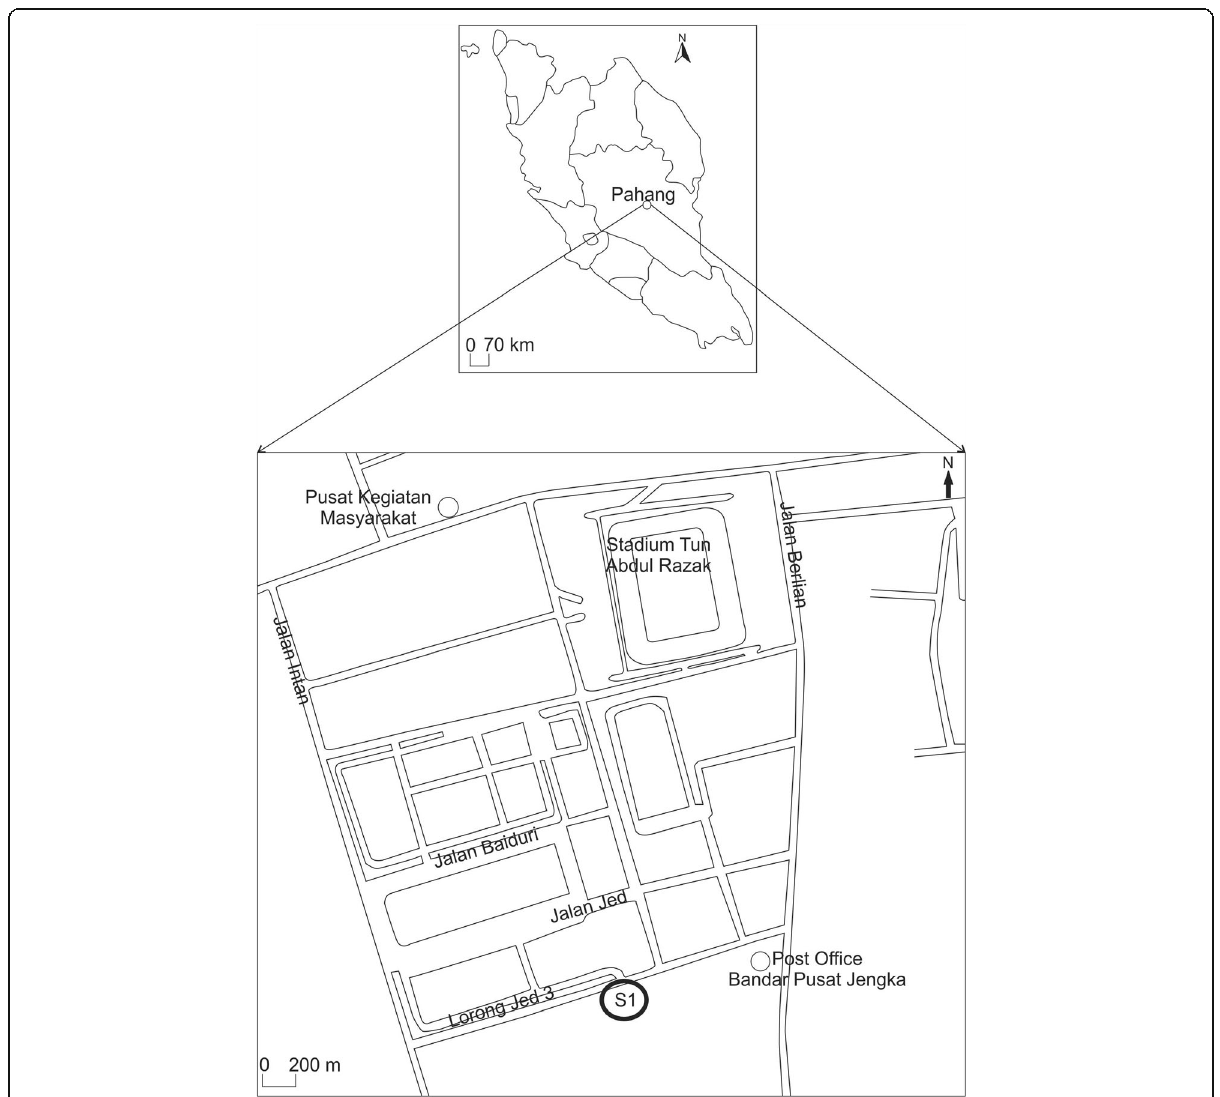
Fig. 1 Location of study area and sampling site (S1) for roadside